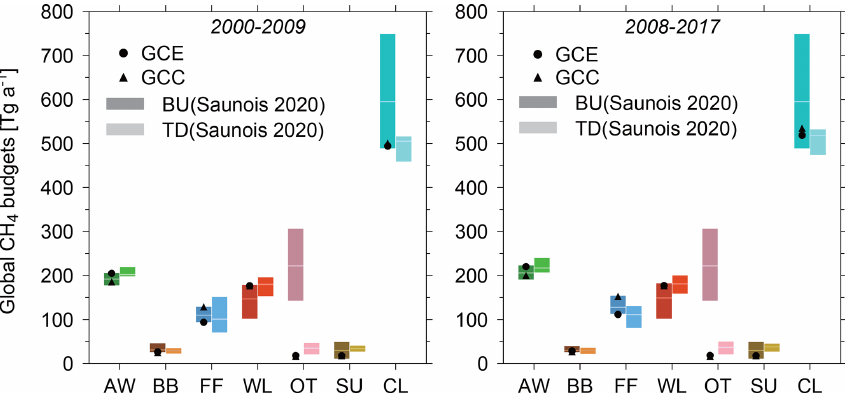
Figure 3. Global CH 4 budgets from main source categories and sinks for the 2000–2009 (2000s) and 2008–2017 (2010s) periods. Categories are grouped based on Table S2 including emissions from agriculture and waste (AW), fossil fuels (FF), wetlands (WL), biomass burning (BB), others (OT), and sinks due to soil uptake (SU) and chemical loss (CL). The bar charts show bottom-up (dark-colored bars) and top-down (light-colored bars) estimates in previous studies as summarized by Saunois et al. (2020). The global CH 4 sources and sinks in the GCE (black circles) and GCC (black triangles) model simulations are also shown. Table S1 summarizes the values presented in the figure.